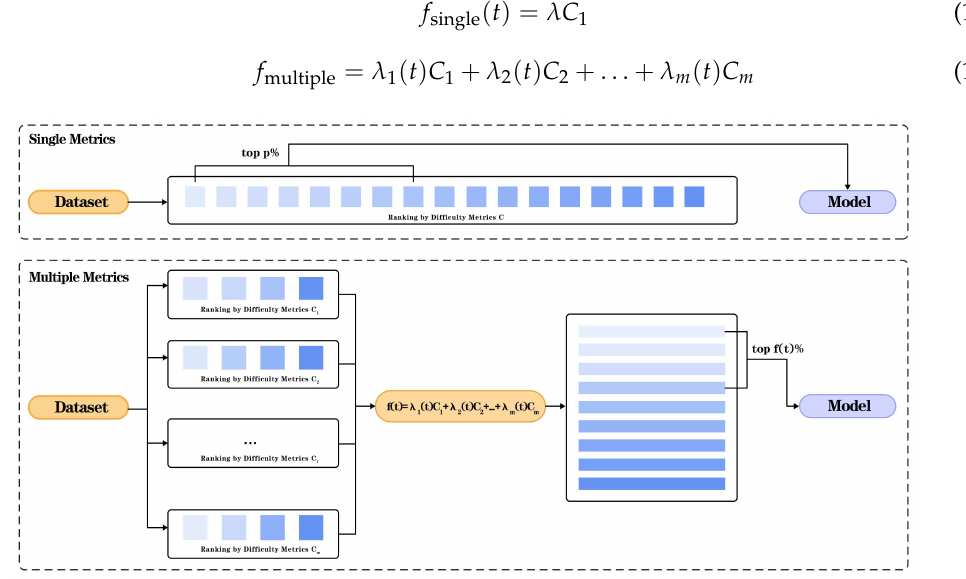
Figure 9. Visualization of a training scheduler based on the threshold.